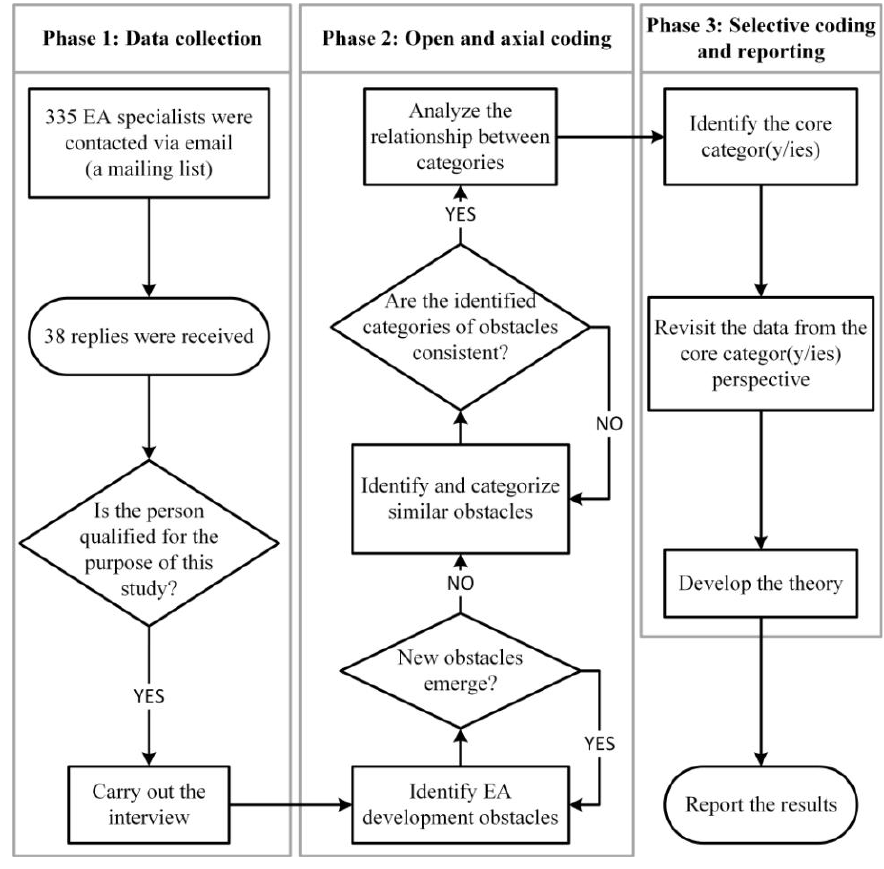
Figure 1. Research